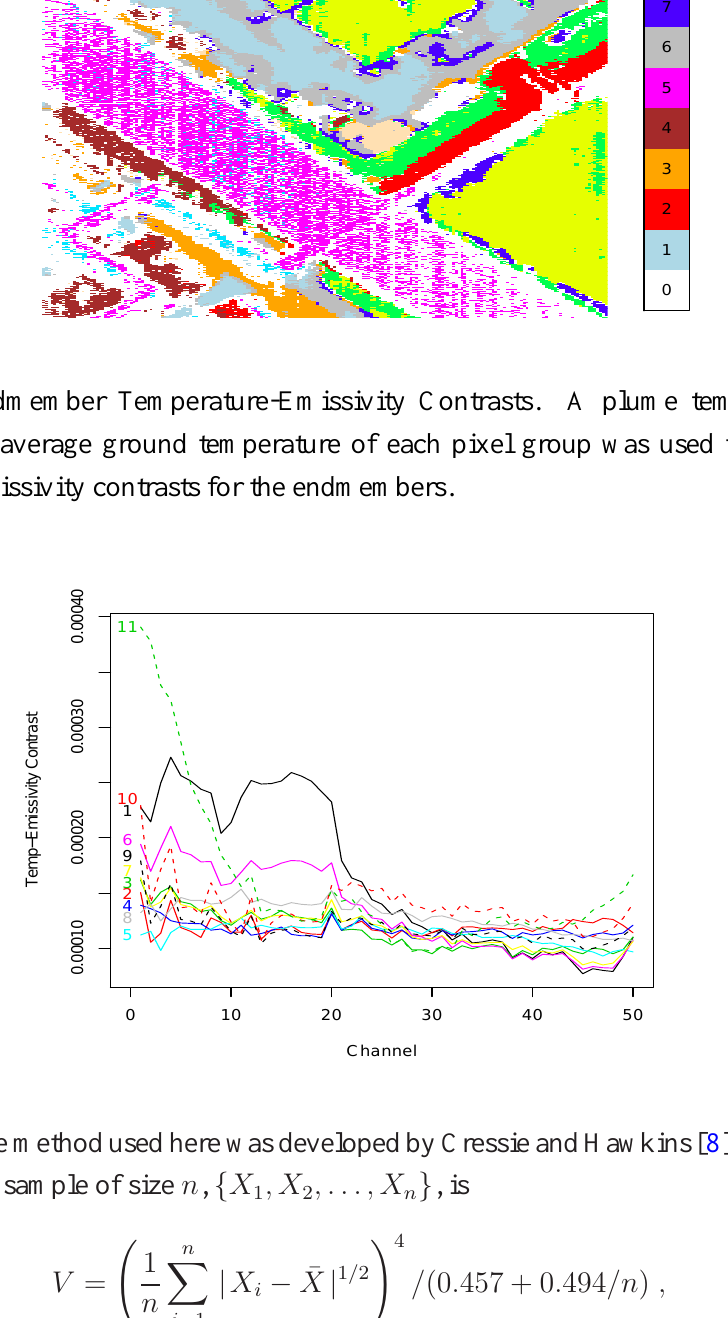
Figure 1. Segmented AHI Image. The 11 pixel group assignments are indicated. White areas are unassigned.